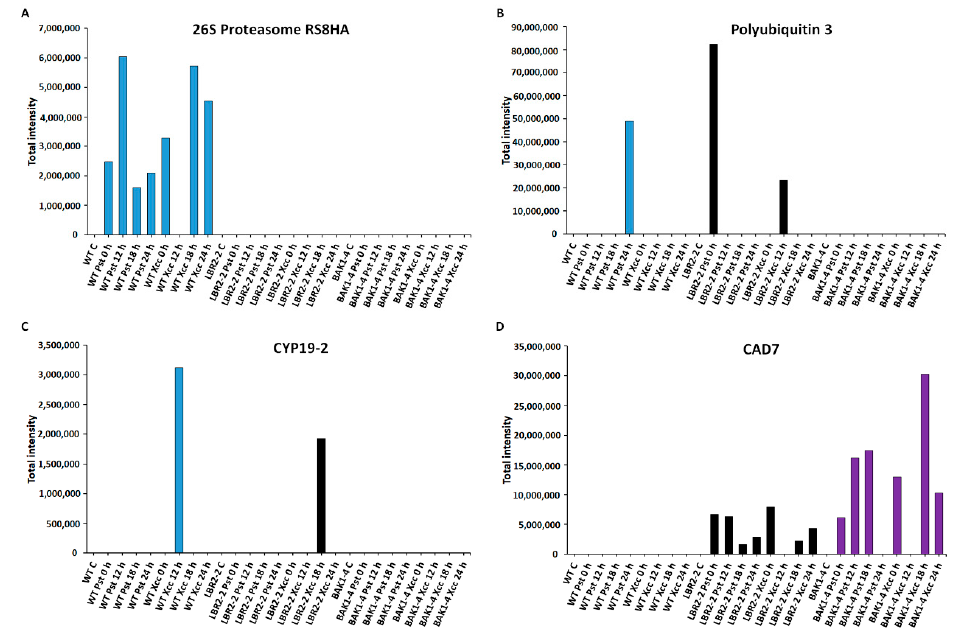
Figure 6. Comparative analyses of total peak intensities of PM-associated proteins involved in metabolic processes . Total peak intensity of selected significant PM-associated proteins for ( A ) 26S proteasome regulatory subunit 8 homolog A (26S Proteasome RS8HA), ( B ) Polyubiquitin 3, ( C ) Peptidyl-prolyl cis-trans isomerase (CYP19-2) and ( D ) Cinnamyl alcohol dehydrogenase 7 (CAD7). Data from the WT are indicated in blue, the lbr2-2 mutant in black and the bak1-4 mutant in purple, with time periods of 0–24 h as indicated. Figure 3A–D analysed proteins that are involved in perception and signalling , such as somatic embryogenesis receptor kinase 4 (SERK4)/BAK1-like 1 (BKK1), BAK1- interacting receptor-like kinase 2 (BIR2), receptor-like protein 51 (RLP51) and L-type lectin-domain containing receptor kinase VII.1 (LecRK-VII.1). The perception signalling function by receptors and/or co-receptors is key to the recognition of MAMPs during plant defence responses. In addition, PM-localised PRRs are either receptor-like proteins (RLPs) or receptor-like kinases (RLKs). As presented in Figure 3A, SERK4/BKK1 is a LRR-RLK protein, which is a BAK1 closest homolog that regulates MTI through association with PRRs [56,57]. Although BKK1 was not identified in the WT and lbr2-2 , it showed an increased accumulation in bak1-4 at early and 18 h LPS Pst -, and a lesser intensity at 0 h LPS Xcc treatments. Figure 3B shows an analysis of another LRR-RLK protein, BIR2, that regulates BAK1 during MTI [28]. BIR2 was not identified in WT and bak1-4 but it increased at 12 h and later LPS Pst -, and at early and 18 h LPS Xcc -treated lbr2-2 . As shown in Figure 3C, RLP51 is a LRR-RLP that represents RLP groups, some of which have been linked to the recognition of MAMPs during plant defences [36,58]. RLP51 was not identified in WT and lbr2-2 . However, the case was different with the bak1-4 mutant, which showed accumulation of RLP51 at 18 h in both LPS chemotypes treatments but was not detected in other time points. LecRK-VII.1 was selected due to the reported involvement of lectin domains in the recognition of ligands with carbohydrate moieties [59], which are also contained in the LPS molecular structure. L-type lectin-domain containing receptor kinase